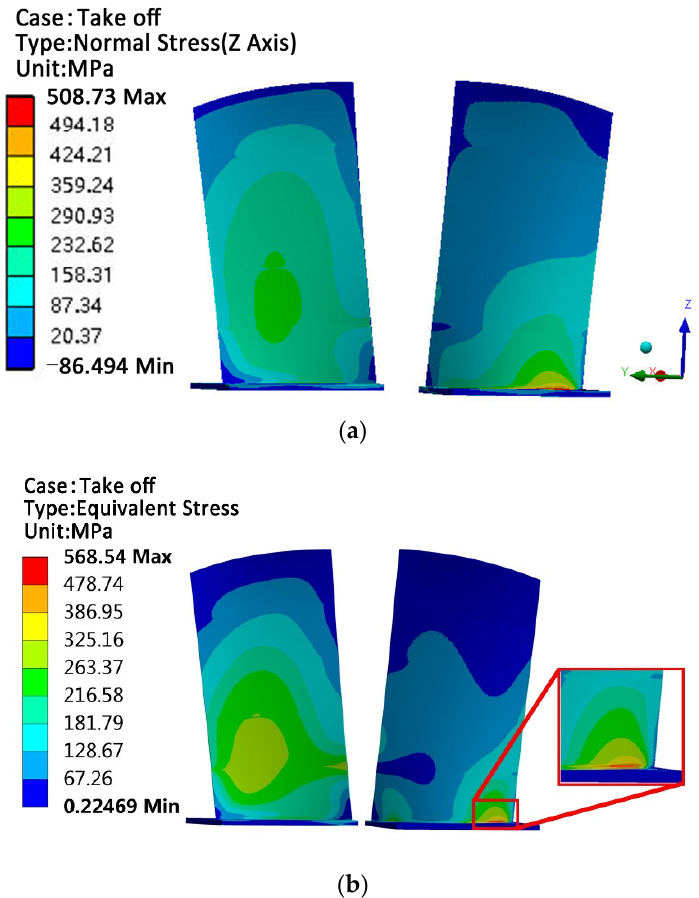
Figure 17. Stress distribution of blade. ( a ) Distribution of normal stress (without the torsional moment); ( b ) Distribution of equivalent stress (including the torsional moment).